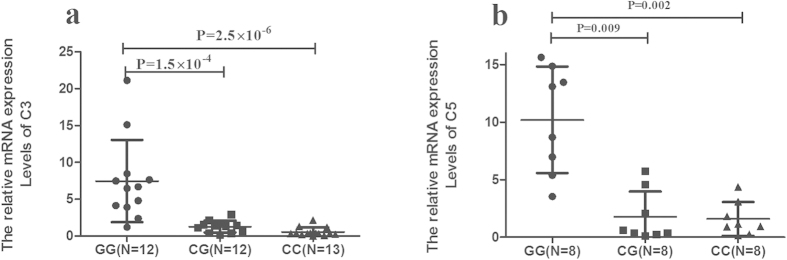
The gene expression of C3 and C5 with different genotypes.mRNA expression of C3 rs408290 and C5 rs2269067 with three different genotypes in PBMCs from healthy controls. The number of different genotype cases of C3 rs408290 (a) (GG: n = 12, CG: n = 12, CC: n = 13) and C5 rs2269067 (b) (n = 8 per group) is shown in the bracket under horizontal axis. Significance was tested by SPSS two independent samples Nonparametric test.